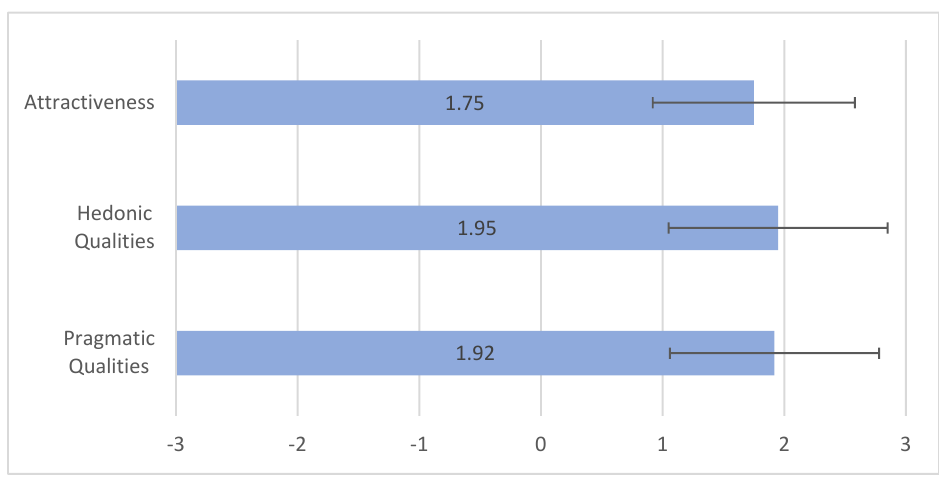
Figure 11. Results for the 3 dimensions evaluated with the AttrakDiff questionnaire.